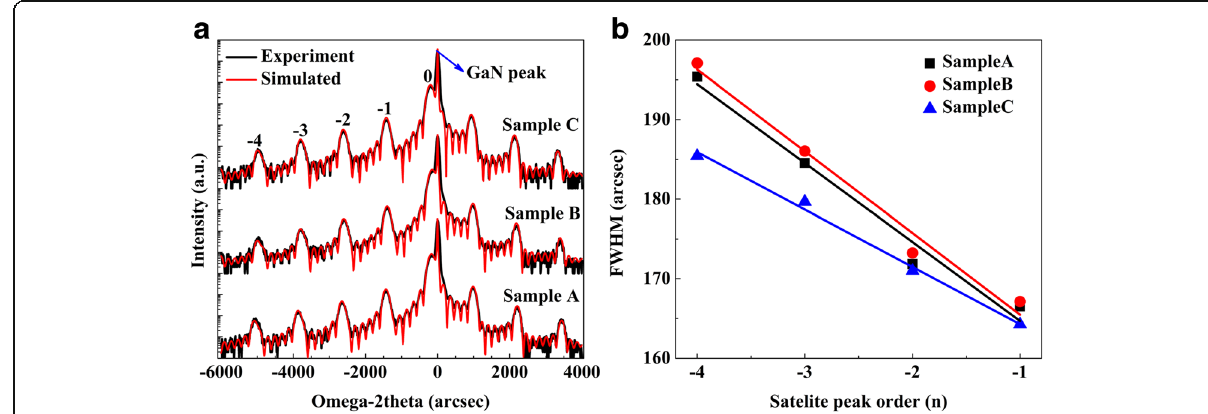
Fig. 1 a HRXRD ω /2 θ scanning curves and simulations of the samples. b The FWHM value as a function of satellite peak order and its linear fitting for the